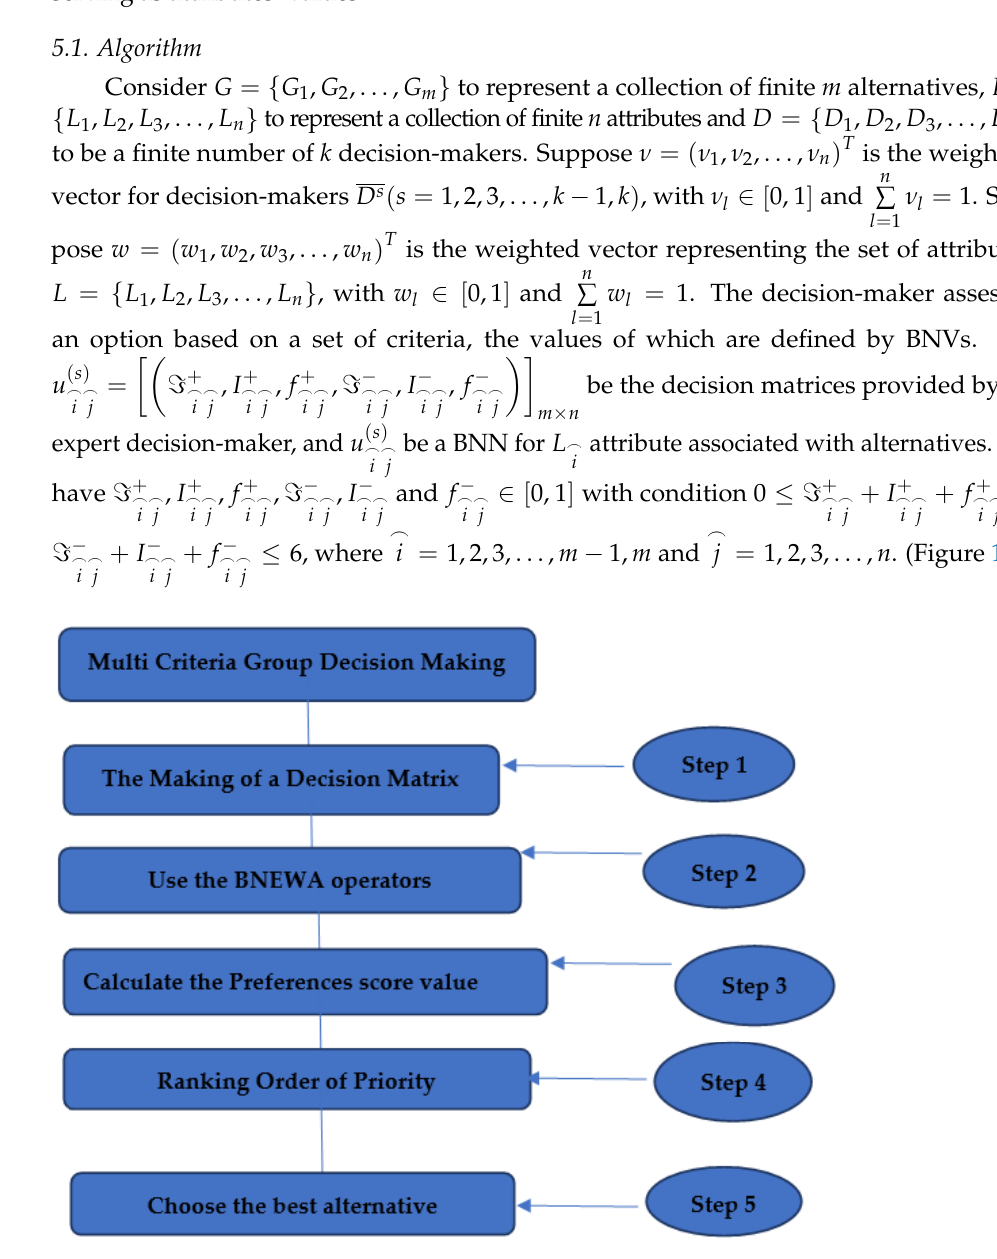
Figure 1. Flow Chart for MCGDM.